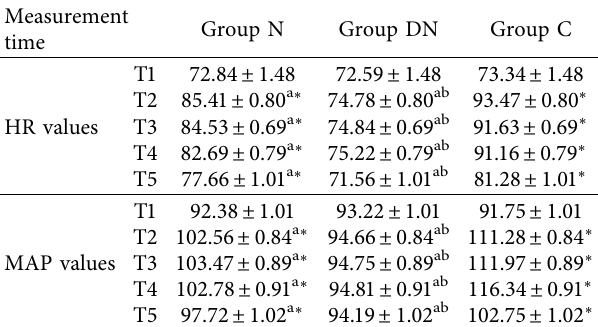
Table 2: Hemodynamic values. Measurement